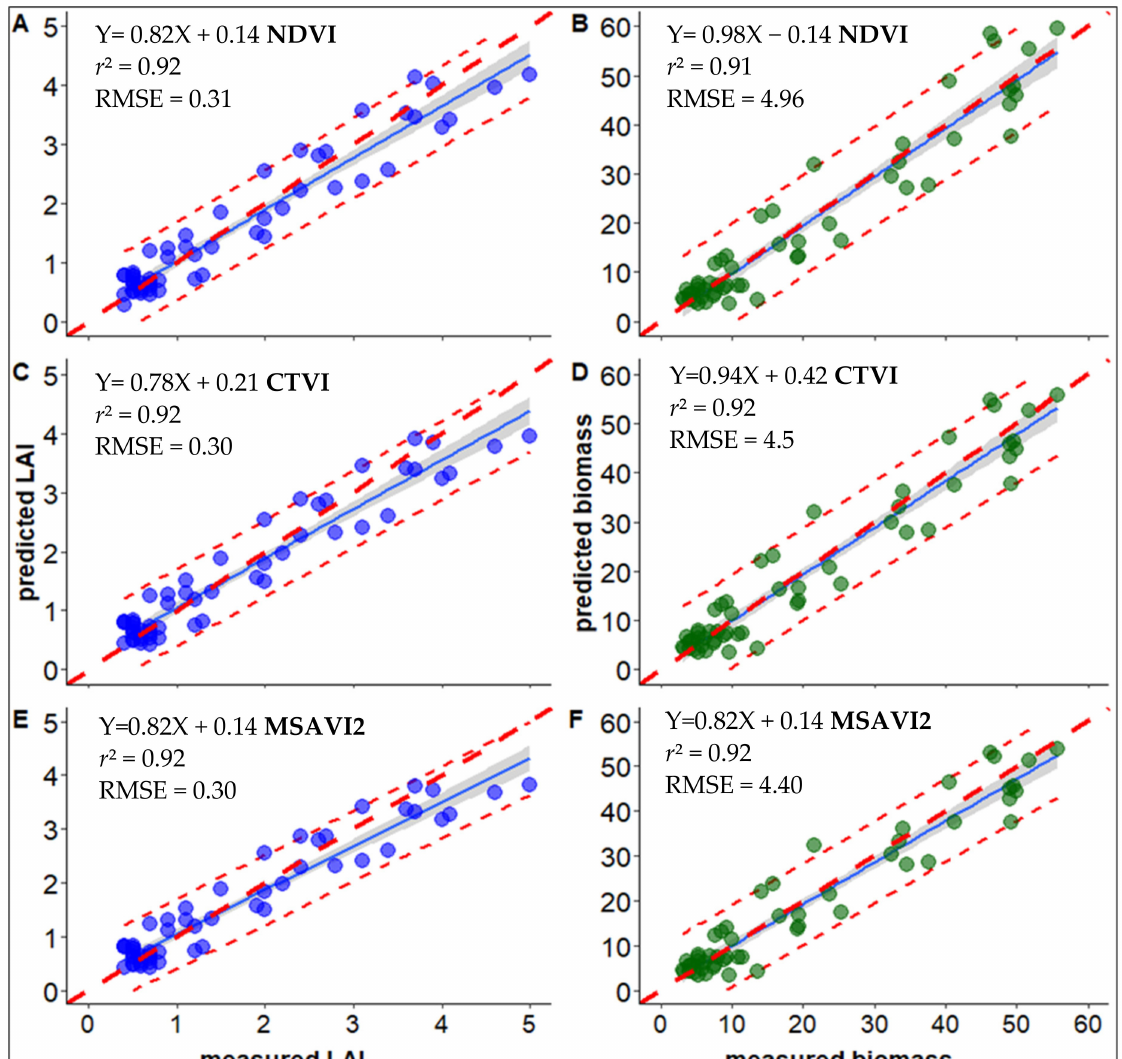
Figure 5. Validation of LAI and biomass prediction models from vegetation indices using 2019 field trial data. Relationship between measured and predicted LAI from NDVI ( A ), CTVI ( C ), MSAVI2 ( E ); biomass from NDVI ( B ), CTVI ( D ), MSAVI2 ( F ). NDVI, CTVI, MSAVI2, GNDVI and SR: vegetation indices; LAI: leaf area index (m 2 m − 2 ); r 2 : coefficient of determination and RMSE: root mean square error; the blue line is the regression line; the dashed dark red line in the graph is the 1:1 line, the dashed light red lines represent the 95% confidence interval of the